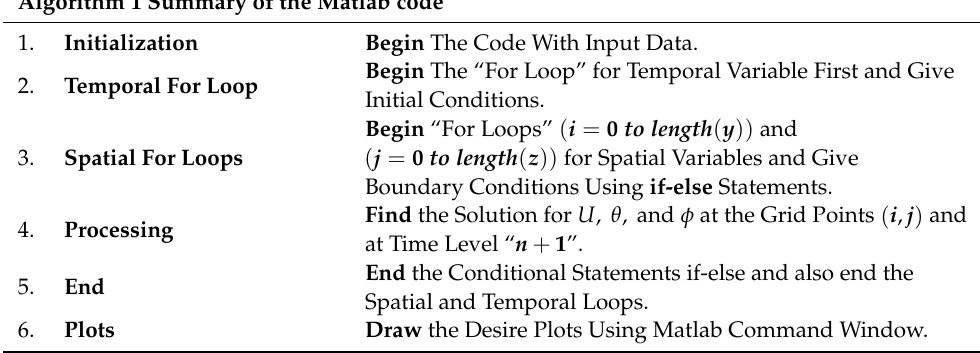
Algorithm 1 Summary of the Matlab